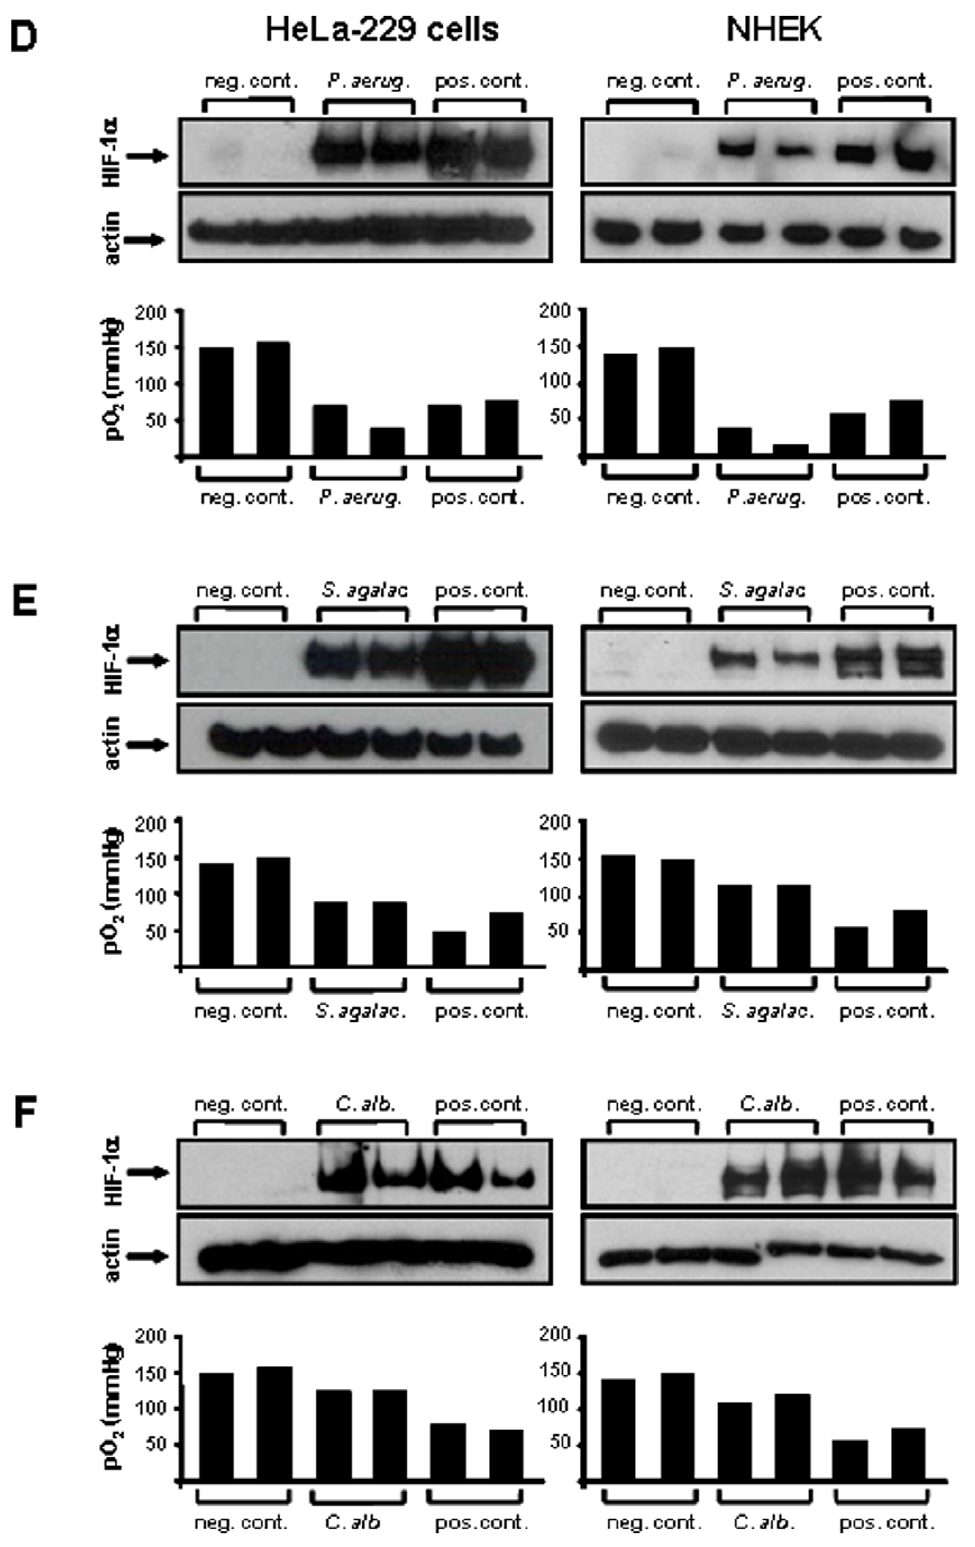
Figure 3. Oxygen-dependent HIF-1 activation in HeLa-229 cells and NHEKs (Normal Human Epidermal Keratinocytes) by bacterial and fungal pathogens. Four to six hours upon infection, HIF-1 activation was determined by Western blotting (loading control: actin). pO 2 levels were quantified in the medium of control and infected cells (D: P. aeruginosa ATCC 27853, MOI 10, infection time: four hours; E: S. agalactiae SK 43, MOI 200, infection time: five hours; F: C. albicans ATCC 90028, MOI 20, infection time: six hours). Negative control: uninfected cells, positive control: hypoxia or DFO (200 m mol/L).